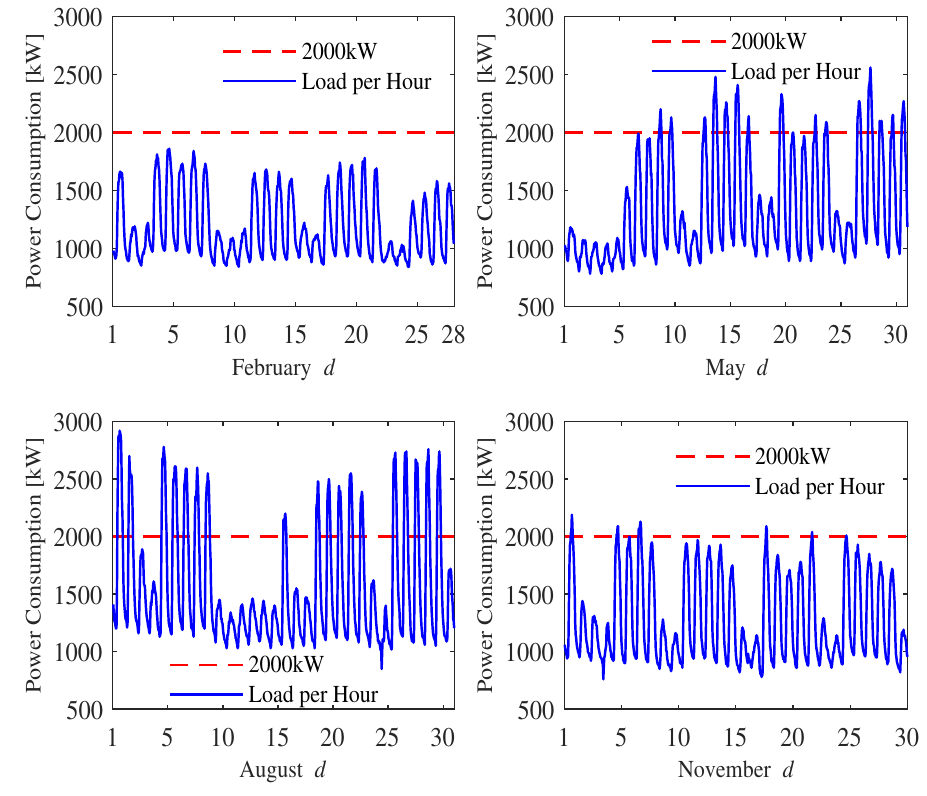
Figure 3. Electricity consumption of the University of the Ryukyus in four different months in 2019.